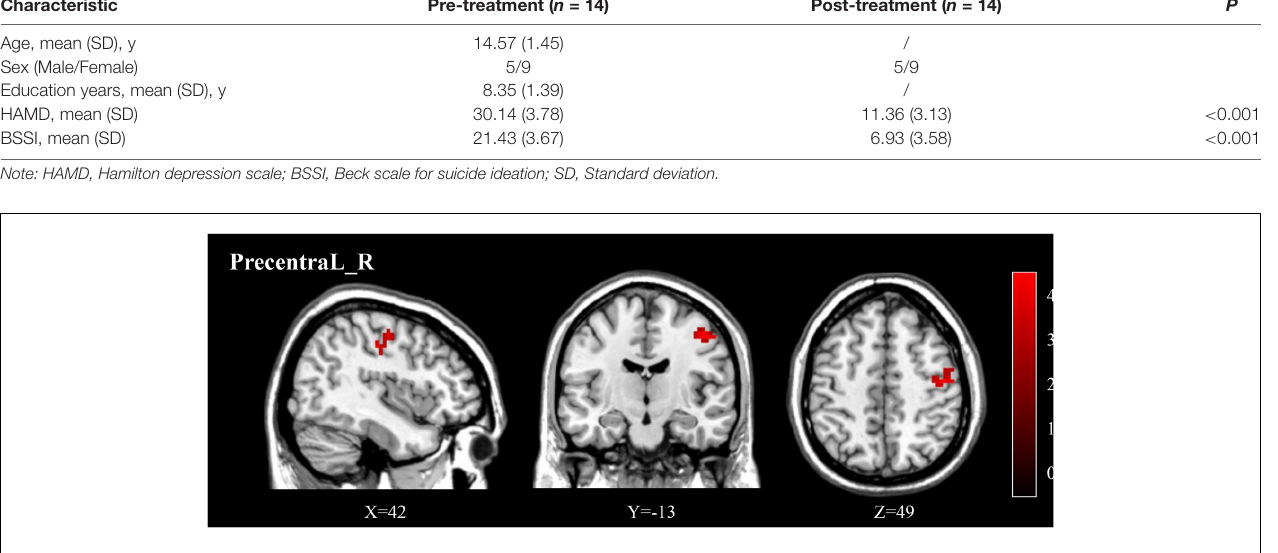
TABLE 1 | Demographics and clinical characteristics pre/post-treatment.